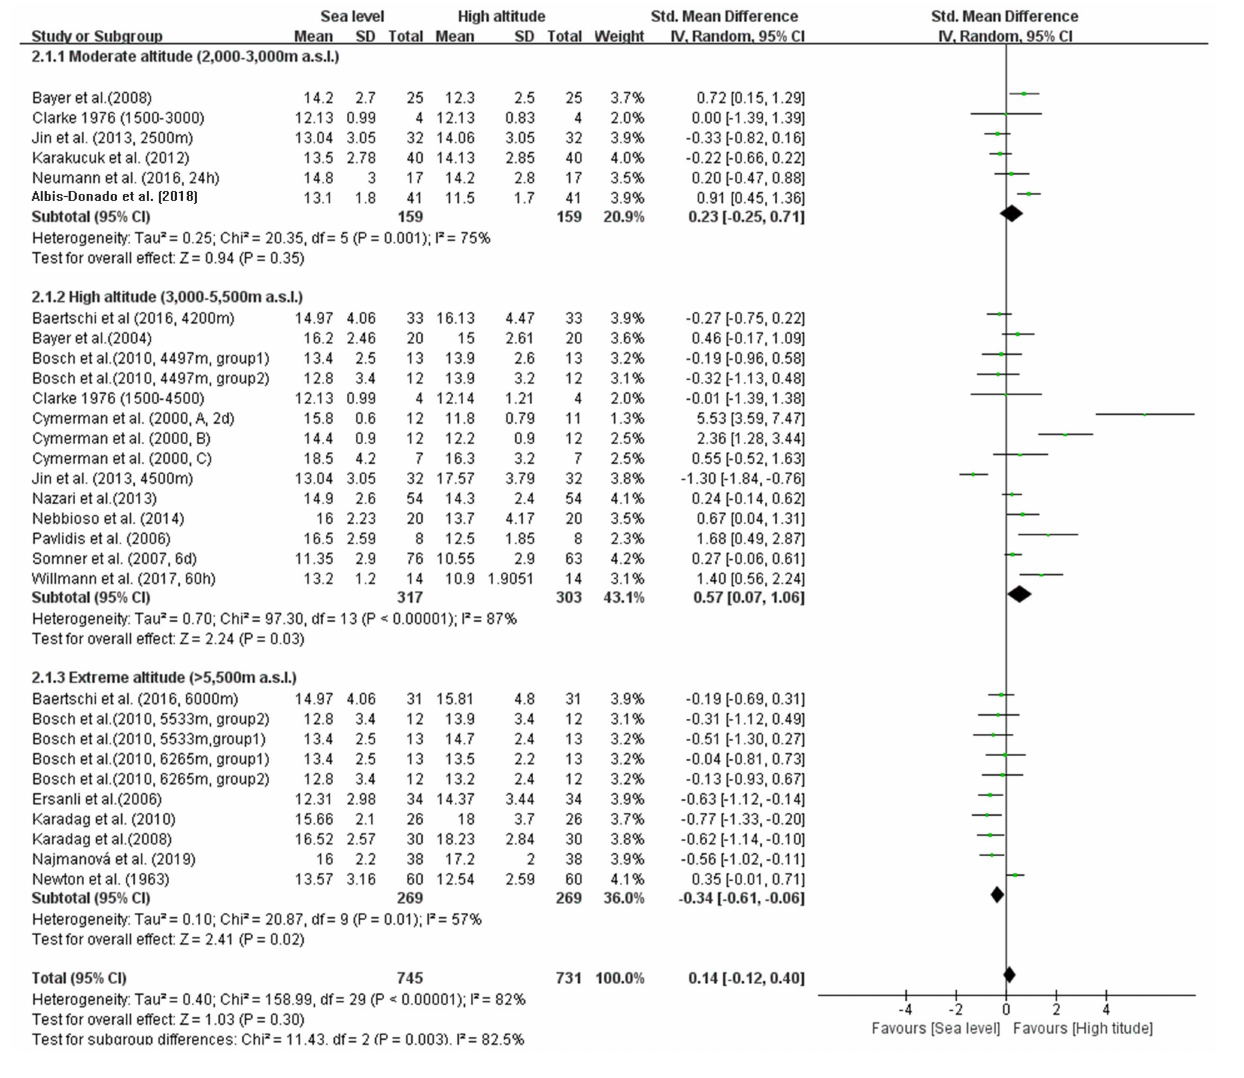
FIGURE 3 | Forest plot of subgroup analysis at different altitude